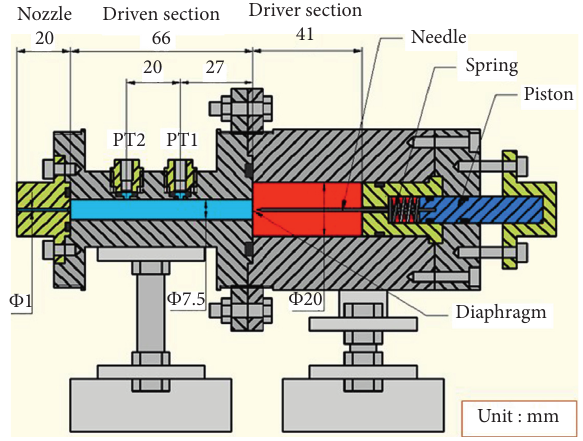
Figure 1: Experimental microshock